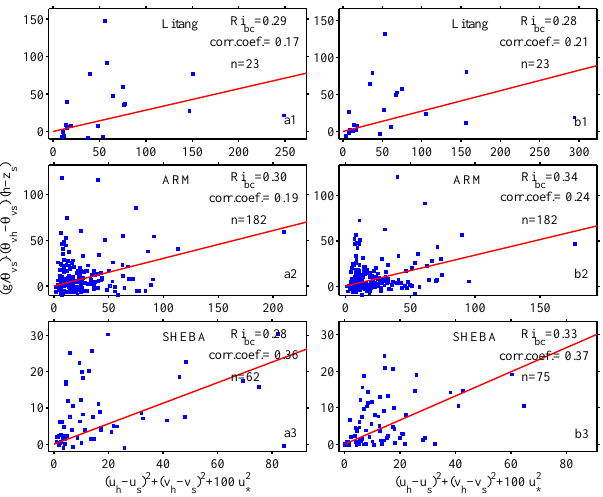
Figure 6. Linear fitting method inferred Ri bc for UBLs, with z s = 0 . 1PBLH (left) and z s = z SAL (right). The red solid lines are the best linear fittings and their slopes represent the values of Ri bc